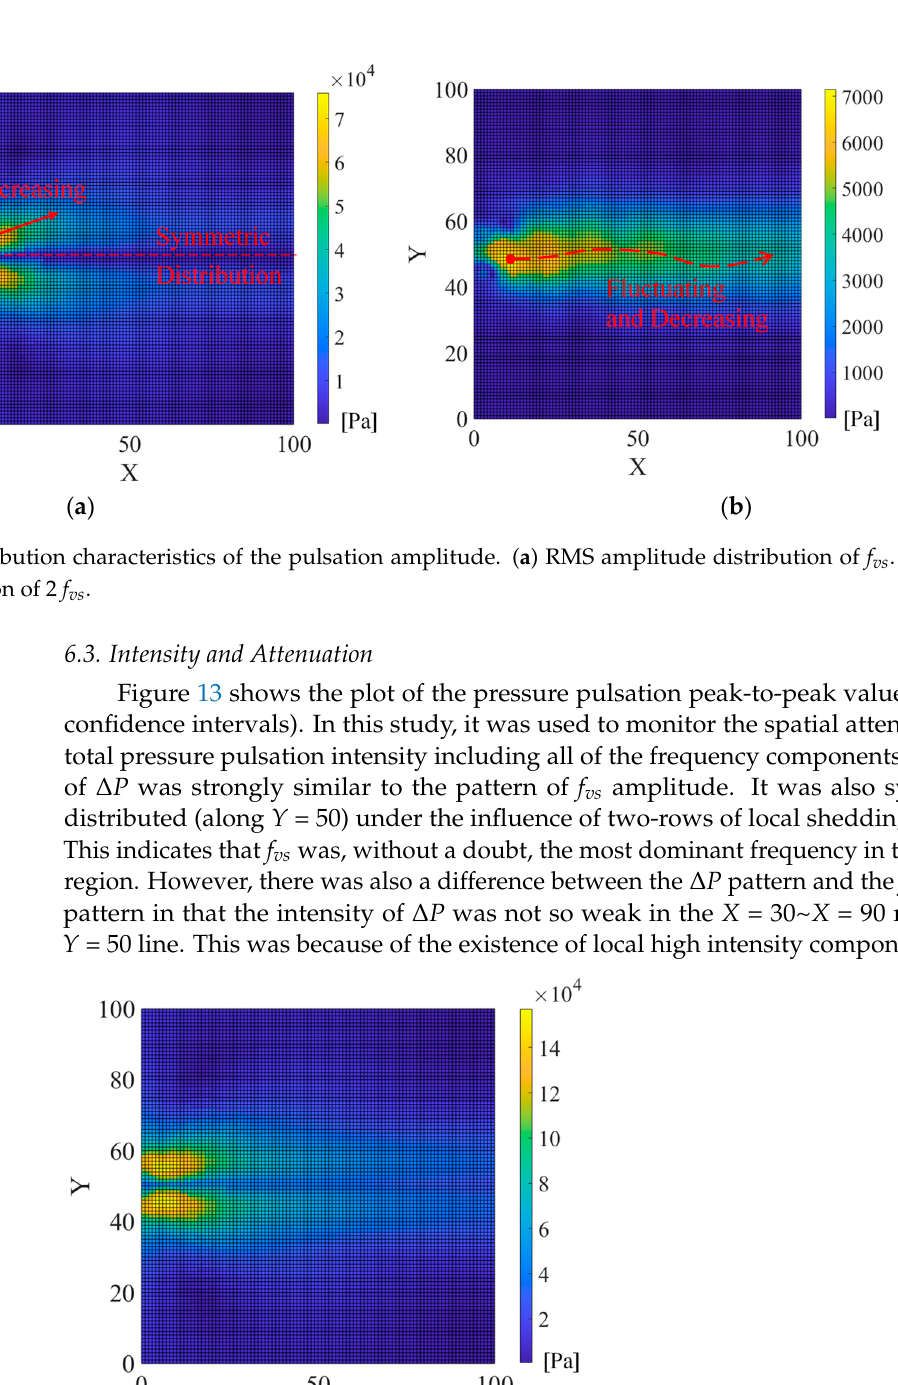
Figure 14. The distribution of dominant frequencies f vs and 2 f vs. 6.5. Phase and Phase Difference The analysis of the phase and phase difference, based on PTN, demonstrated in this study represents breakthrough in terms of the understanding of pressure pulsation, as compared to traditional analysis. Firstly, it was necessary to set an initial reference point. In this case, the initial reference point P ini was located on the centre of the trailing edge of the hydrofoil ( X = 0, Y = 50), as illustrated. The phase of f vs on the initial point was defined as the initial phase. The parameter Δ φ represents the phase difference between any point and an initial point, and this is plotted in Figure 15a.